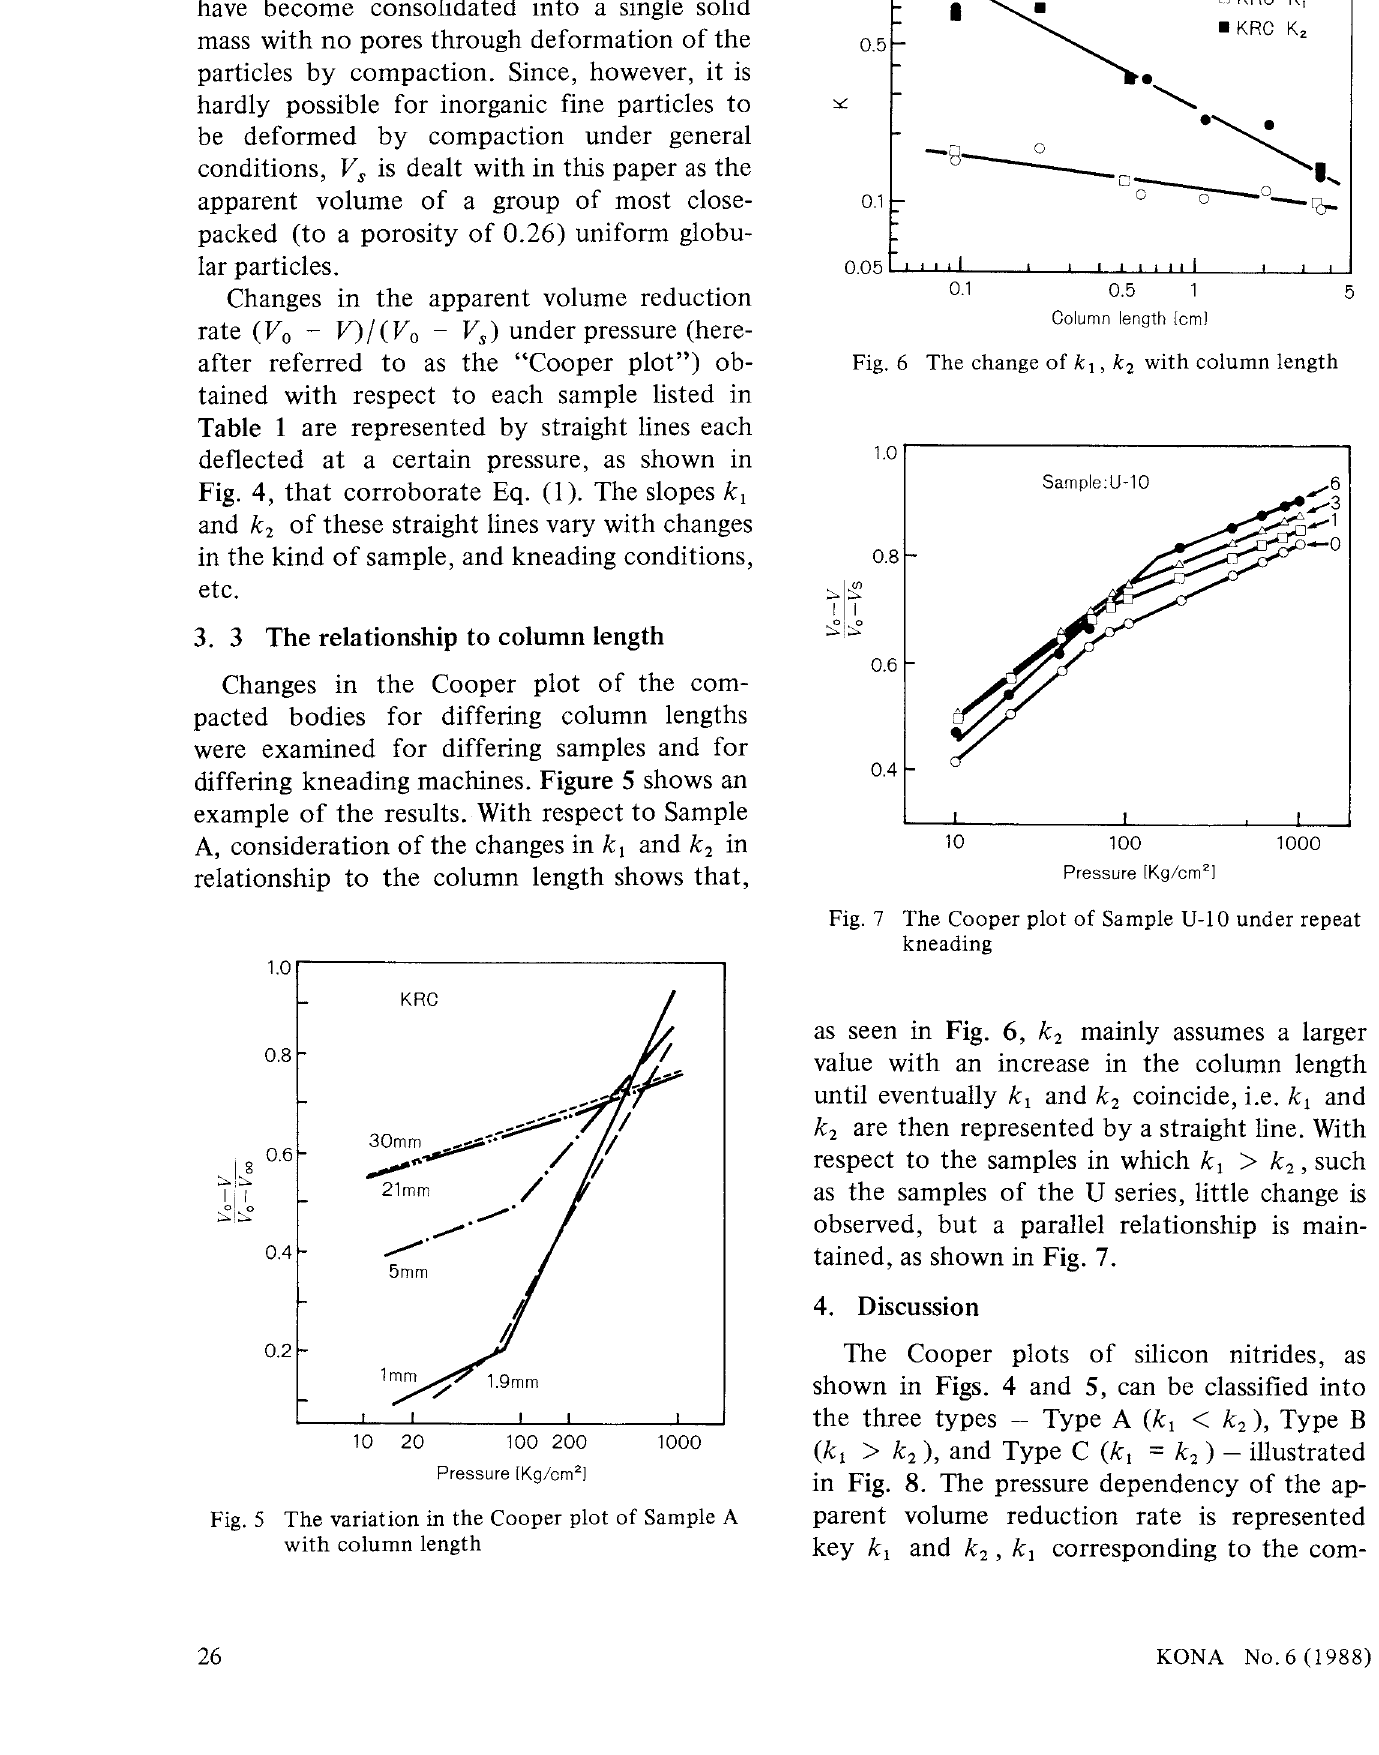
Fig. 6 The change of k